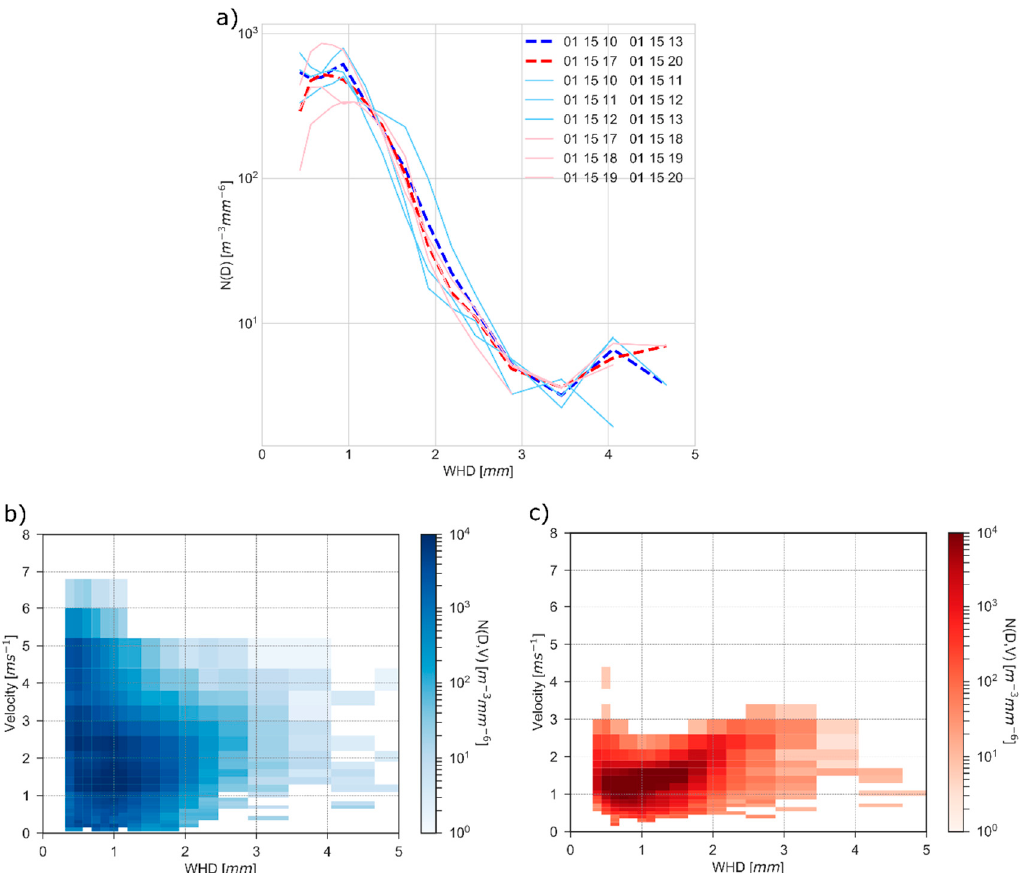
Figure 7. ( a ) Particle Size Distribution averaged for the time interval measured by Parsivel for mountain wave period (Period A, in blues) and rotor period (Period B, in reds). ( b , c ) Particle size and velocity distribution for ( b ) Period A and ( c ) Period B. Dates are indicated considering the format MM-DD HH (month-day hour) in UTC.